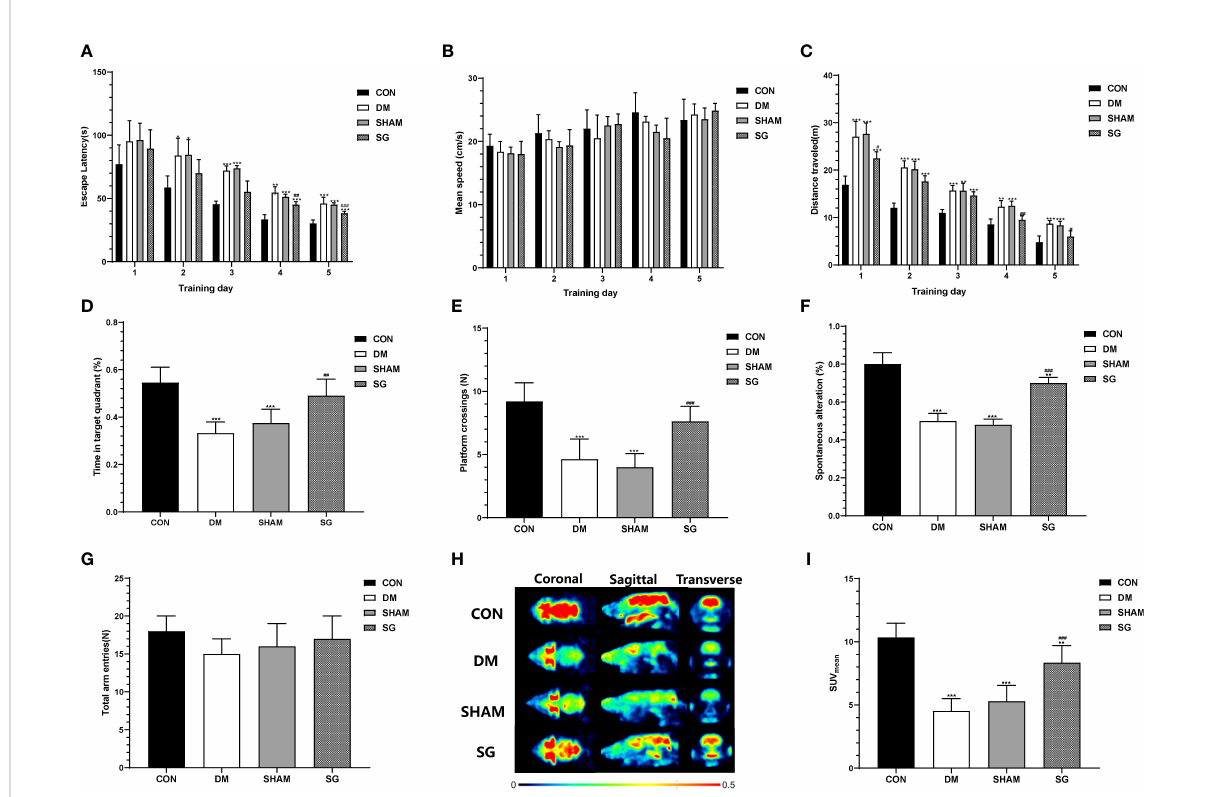
FIGURE 3 SG induced signi fi cant improvement in the animal behaviors in the Morris water maze test (A-E) and Y-maze test (F, G) , and PET imaging system validated the improvement of glucose uptake in brain (H, I) . Data were expressed as means ± SEM for n = 10 per group. * p < 0.05 vs. CON group, ** p < 0.01 vs. CON group, *** p < 0.001 vs. CON group; # p < 0.05 vs. SHAM group, ## p < 0.01 vs. SHAM group, ### p < 0.001 vs. SHAM group. PET, positron-emission tomography; SUV Mean , the average standard uptake value; CON, control; DM, diabetes mellitus; SHAM, sham operation; SG, sleeve